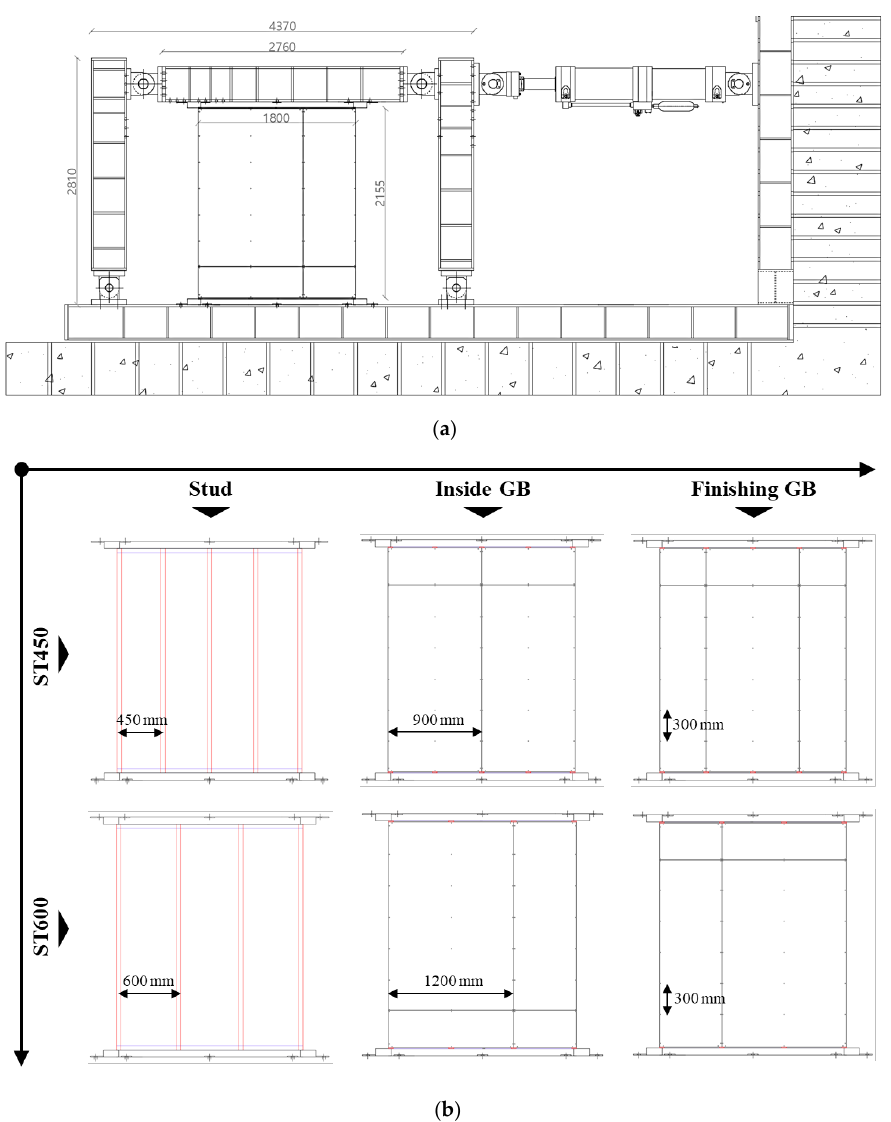
Figure 9. Test specimens: ( a ) Test setting; ( b ) Distribution of studs and gypsum boards of ST600 and ST400 specimens.